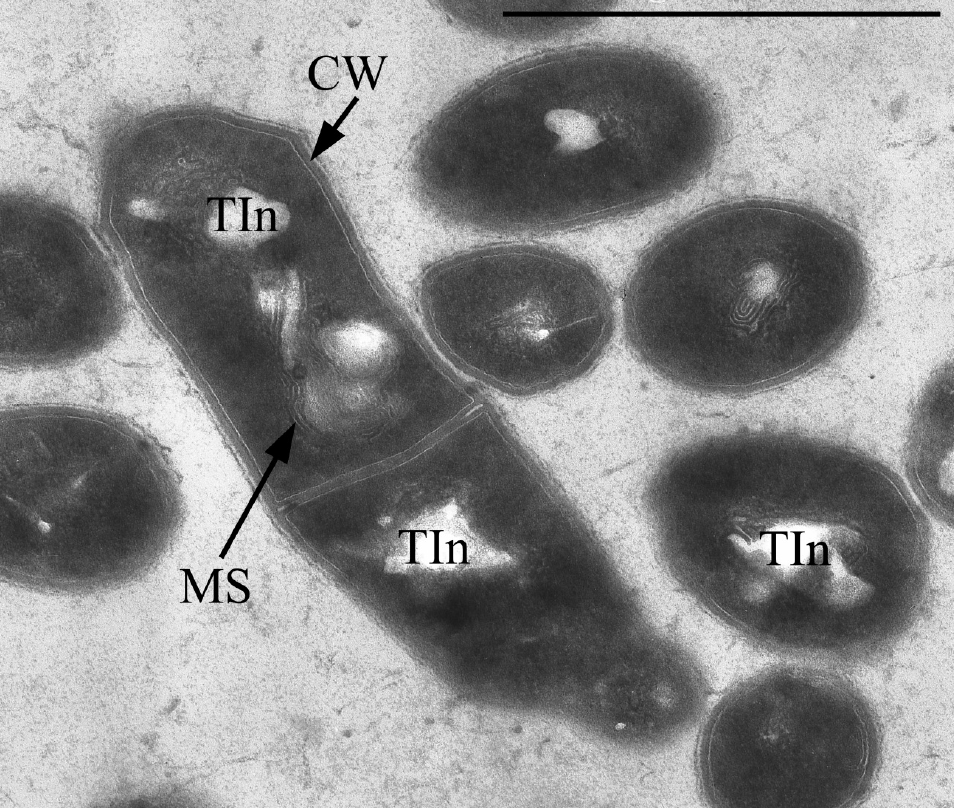
Figure 3. Ultrathin section of Gordonia polyisoprenivorus 135 vegetative cells grown in LB. Designation: CW—cell wall; TIn—electron-transparent inclusion; MS—membrane-like structures. Transmission electron microscopy. Bar—1 μ m.